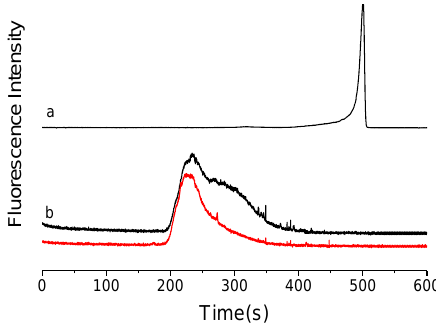
Figure 1. Electropherograms of quantum dots (QDs)-IgG-Cy5 conjugation with detection in 612 nm channel (Black) and 670 nm channel (Red). ( a ) QDs alone, 2 μM and ( b ) QDs-IgG-Cy5, 2 μM. CE conditions: 25 mM borate buffer (pH 9.3) at 18 kV. λ = 420 nm. ex